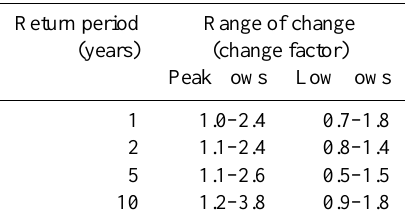
Table 4. Factor change in daily peak/low flow extremes for Nyando catchment and specific return